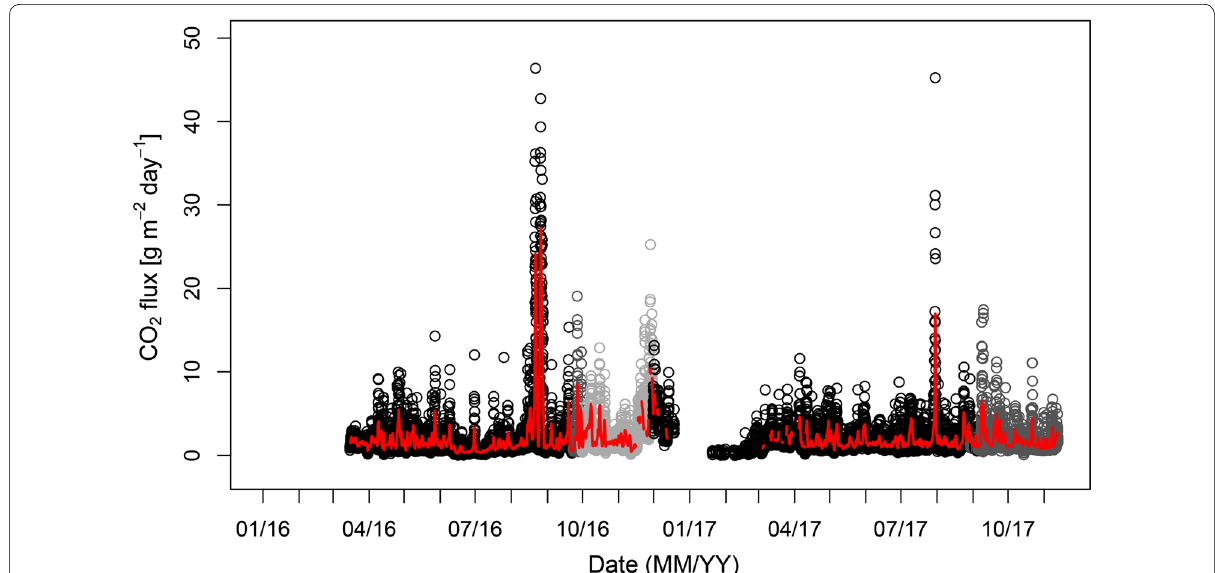
Fig. 3 Time series of soil CO 2 flux from January 2016 to November 2017 (black circle). The dark and light gray circles correspond to soil CO 2 flux data calculated with air temperature data of the weather station and interpolated air temperature data, respectively. The red line shows the daily average values of the data